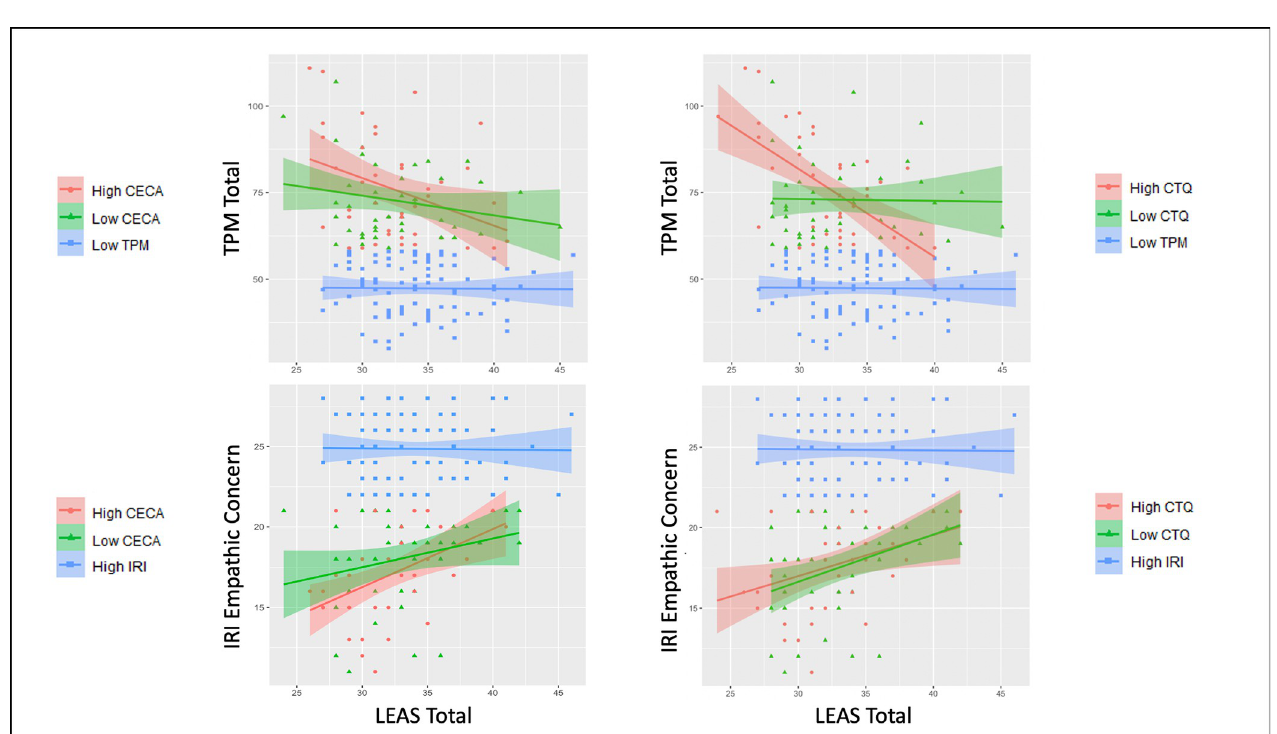
Fig 4. Analysis of individuals with high levels of psychopathy with vs. without early adversity. This figure shows correlations in high-psychopathy/low- empathy groups between Levels of Emotional Awareness (LEAS) Total Scores and both Triarchic Psychopathy Measure (TPM) Total scores and Interpersonal Reactivity Index (IRI) Empathic Concern scores, separated by high vs. low levels of early adversity (based on median splits). Early adversity measures included the Childhood Experiences of Care and Abuse questionnaire (CECA) and the Childhood Trauma Questionnaire (CTQ). Unlike in Fig 2 , high and low early adversity levels were taken only from individuals with scores above and below the median for the TPM and IRI, respectively. Although the focus of these analyses was restricted to high-psychopathy/low-empathy individuals, for the interested reader we also illustrate the absence of any relationships observed in the remaining low-psychopathy and high-empathy individuals (blue